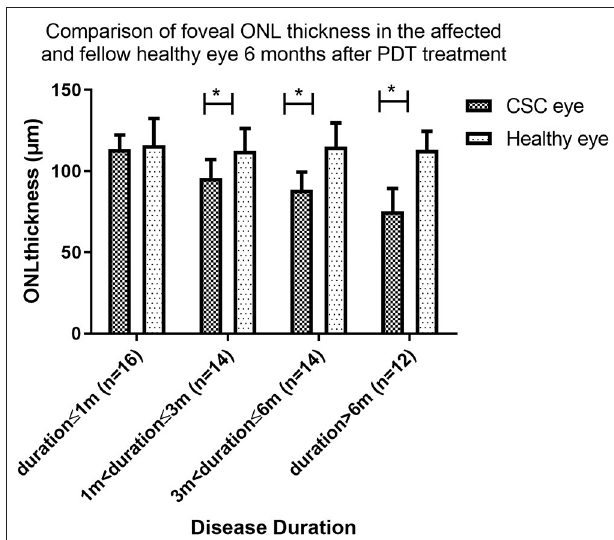
FIGURE 5 | Comparison of foveal ONL thickness in the affected and fellow healthy eye 6 months after PDT treatment. At 6 months follow up after PDT, the foveal ONL thickness in patients with disease duration ≤ 1 month eventually recovered to a level comparable to that of the contralateral healthy eye. In patients with disease duration over 1 month, ONL was not restored to this level (* indicates statistical significance).